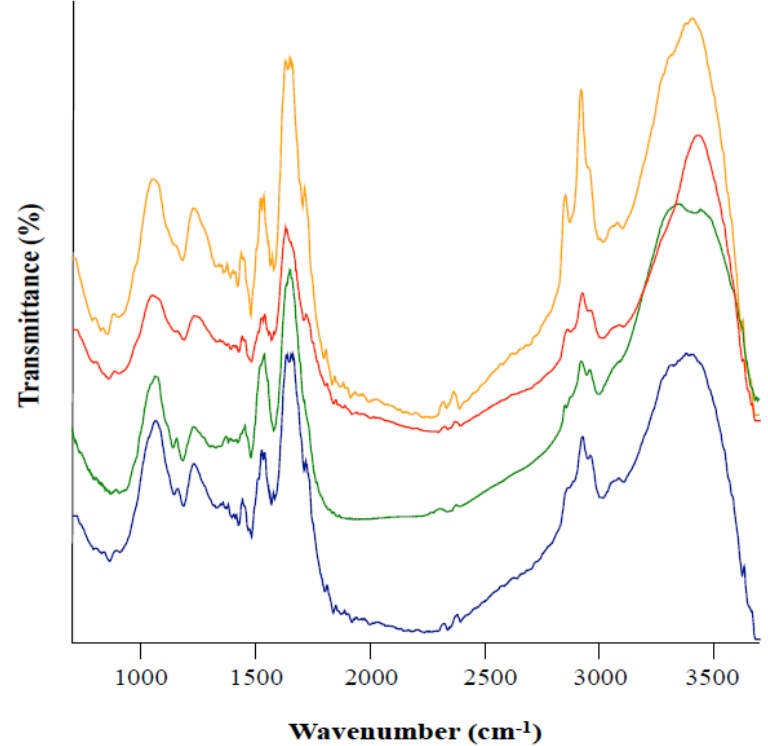
Figure 3. FTIR spectra of melanin extracted from Leptodontidium sp. Me07 mycelia. The mycelia were grown on control Pachlewski medium (orange) or on the same medium amended with tricyclazole (red), kojic acid (blue) or tricyclazole and kojic acid (green). Representative spectra are shown and the experiment was repeated twice (biological replicates) with similar results.